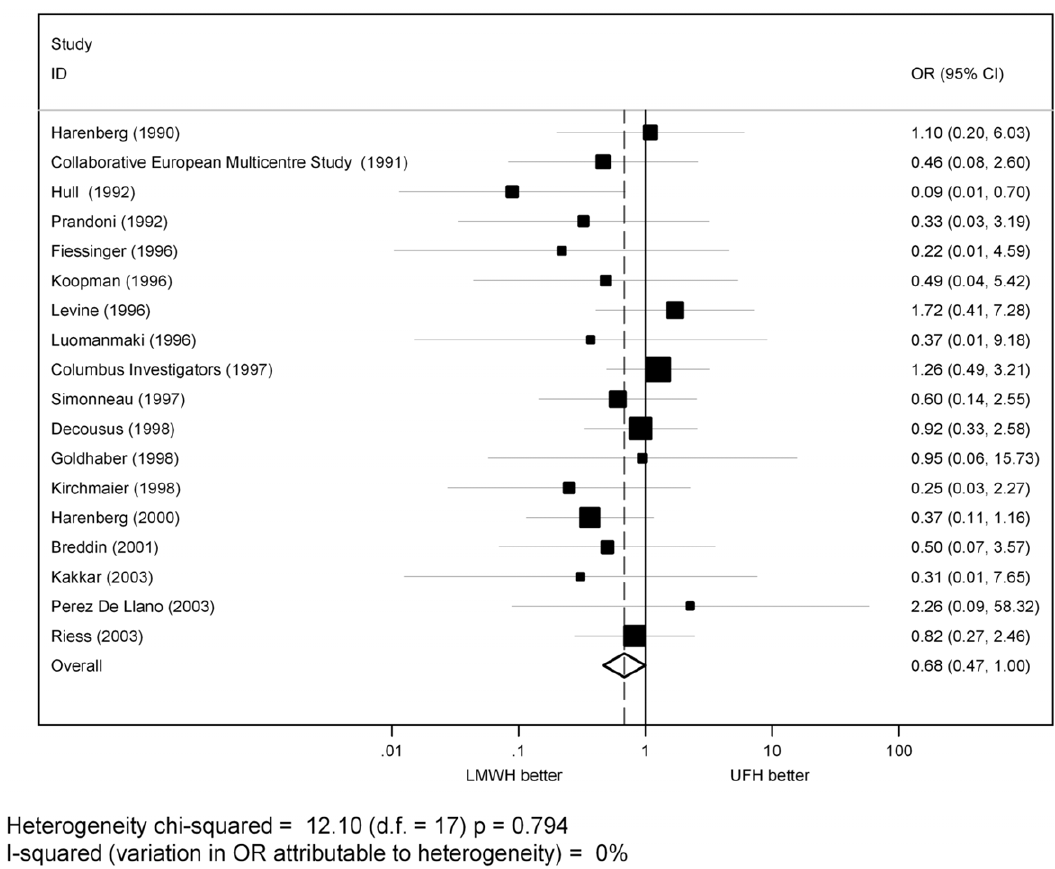
Figure 3. Pooled estimates of OR for major bleedings of LMWH versus UFH in VTE patients.